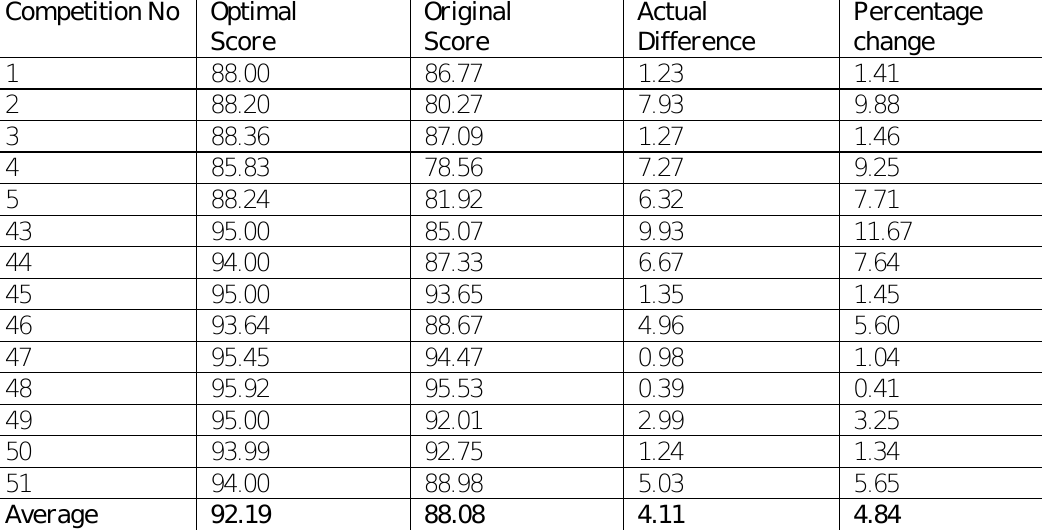
Table 4: Original total score/ optimum total score comparisons using 70/30 predetermined weightings Competition